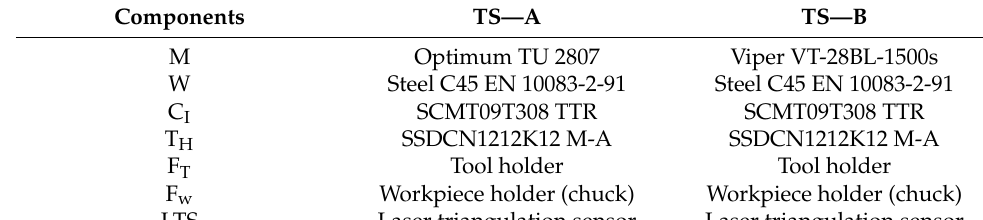
tions). Table 1. Description of technological systems (TS-A-laboratory conditions, TS-B-practical conditions). Components TS—A TS—B M